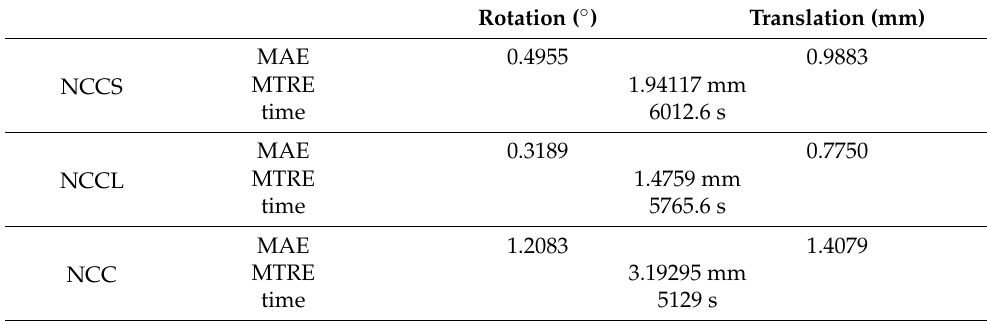
Table 2. Single-resolution experimental results.